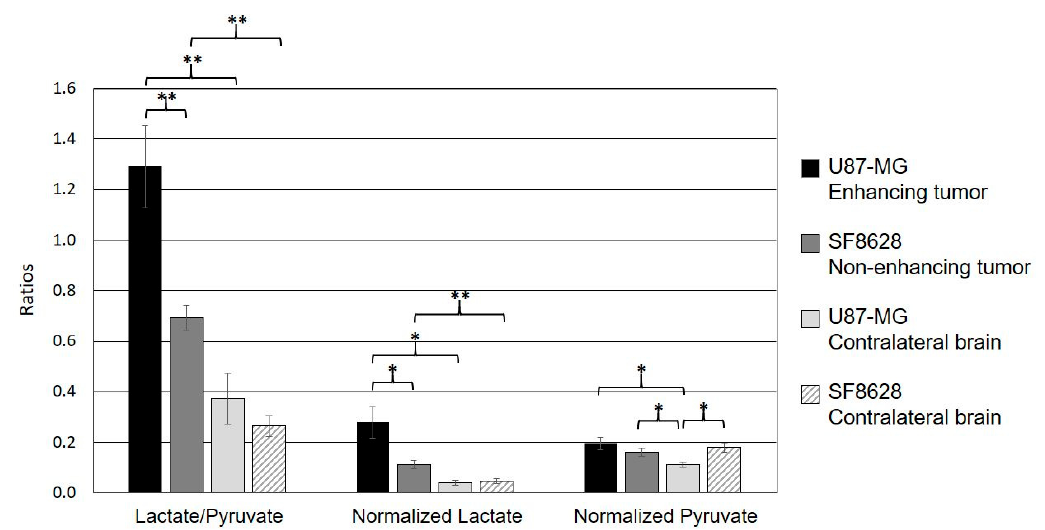
Figure 3. The comparison of quantified metabolic parameters from the two types of tumor models. Both the ratio of lactate to pyruvate (Lactate/Pyruvate) and normalized lactate in the enhancing lesion of the U87-MG models were significantly higher than those in the T2 hyperintense lesion of the SF8628 models. The levels of normalized pyruvate were comparable between the two types of tumor. In both types of tumor, the levels of Lac/Pyr and normalized lactate were significantly higher than those in contralateral normal-appearing brain tissue. The level of normalized pyruvate in the contralateral brain tissue of the rats bearing glioblastoma was significantly smaller than that in its enhancing lesion, which was comparable to the level of normalized pyruvate in the non-enhancing lesion and the contralateral brain tissue of the rats bearing a diffuse midline glioma. In contrast, the rats bearing a diffuse midline glioma displayed a comparable level of normalized pyruvate between its ipsilateral hyperintense lesion and the contralateral normal tissue (* p < 0.05; ** p < 0.01). Error bars indicate the standard error of the mean.